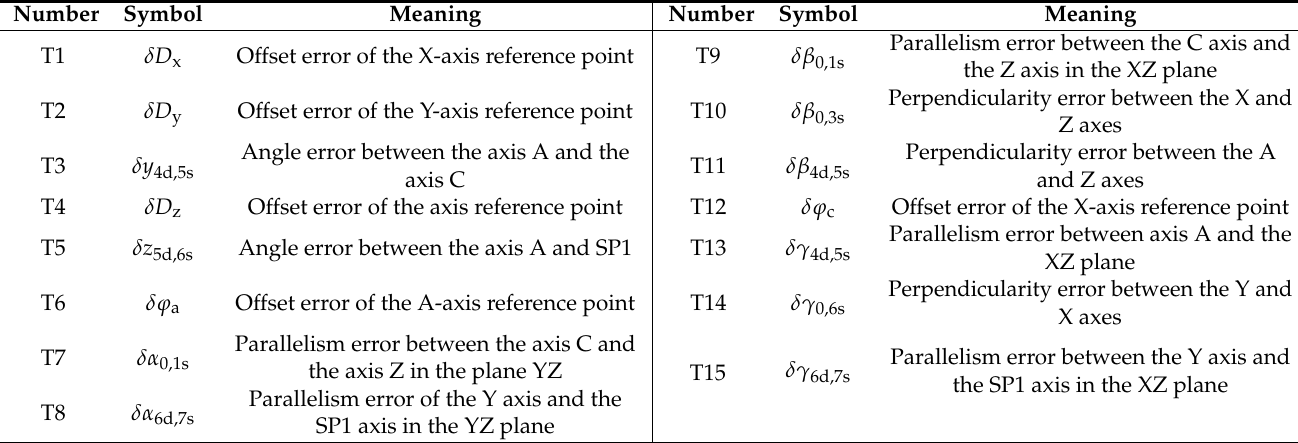
Table 1. Assembly errors of the gear grinding